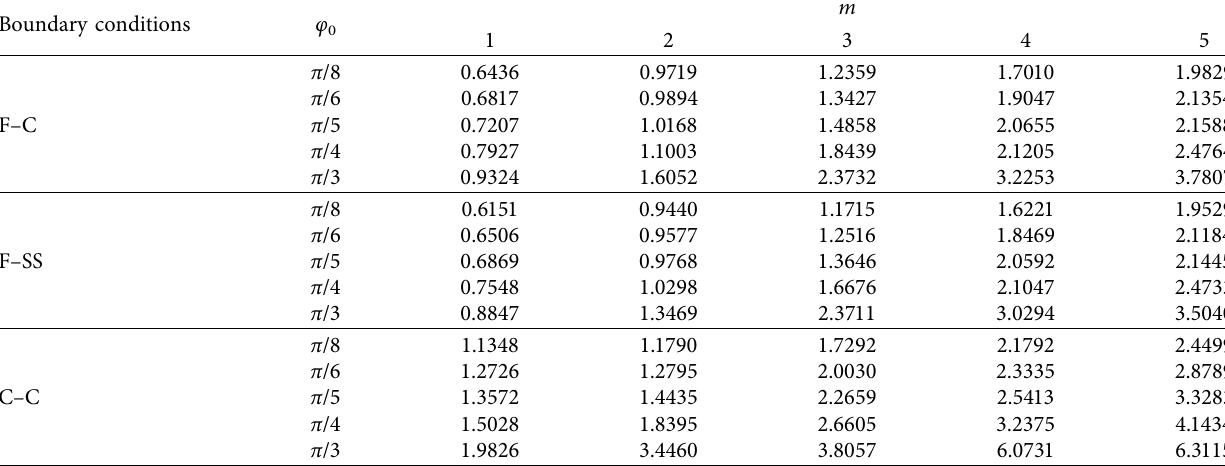
� π /2, R � 1m, h � 0.06m, and n � 0 ( φ 1